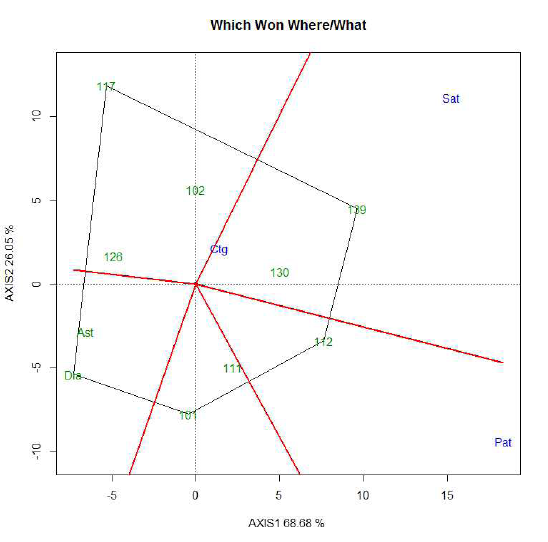
Figure 4: Polygon view of GE interaction for CIP potato clones over 3 locations during 2012-13 (Ctg=Chittagong, Pat=Patuakhali and Sat= Satkhira)